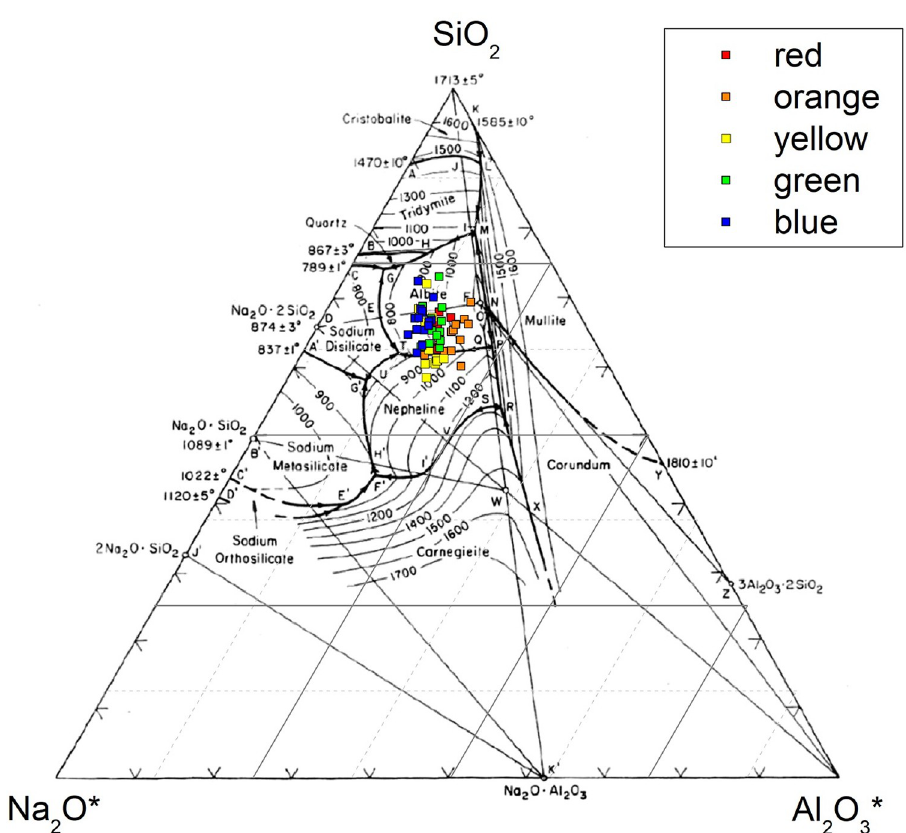
Fig 3. A plot of m-Na-Al glasses in the Na 2 O-Al 2 O 3 -SiO 2 phase diagram. The oxides from the base composition are further reduced into three components (SiO 2 , Al 2 O 3 � and Na 2 O � )–the FeO, MgO and CaO are transmuted to Al 2 O 3 (labelled Al 2 O 3 � ), using a transmuting factor of 0.71, 1.26 and 0.91, respectively (Rehren 2016, pers. comm.). The K 2 O is incorporated into Na 2 O (labelled Na 2 O � ) transmuted by the factor of 0.66. The base phase diagram is from Levin and McMurdie